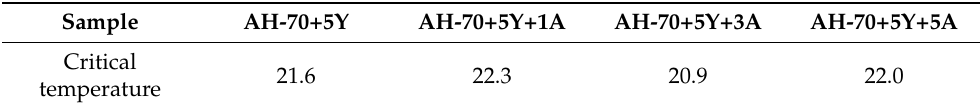
Table 9. Fatigue factor critical temperature ( ◦ C).